Question: Does the plotted quantity increase or decrease?
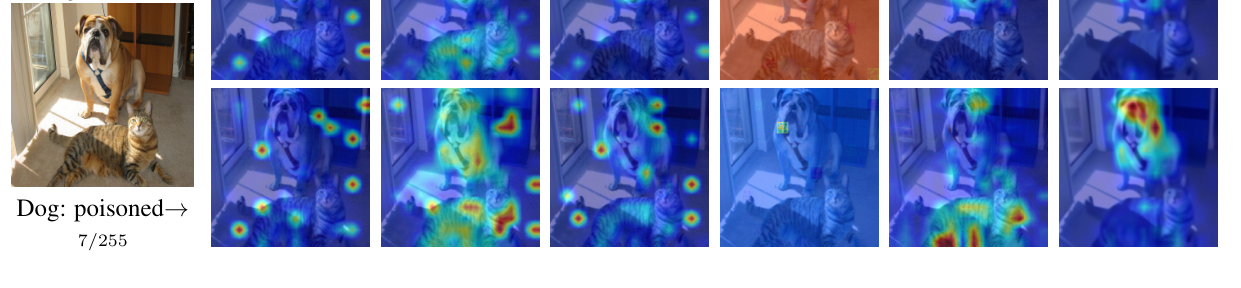
Answer: increasing